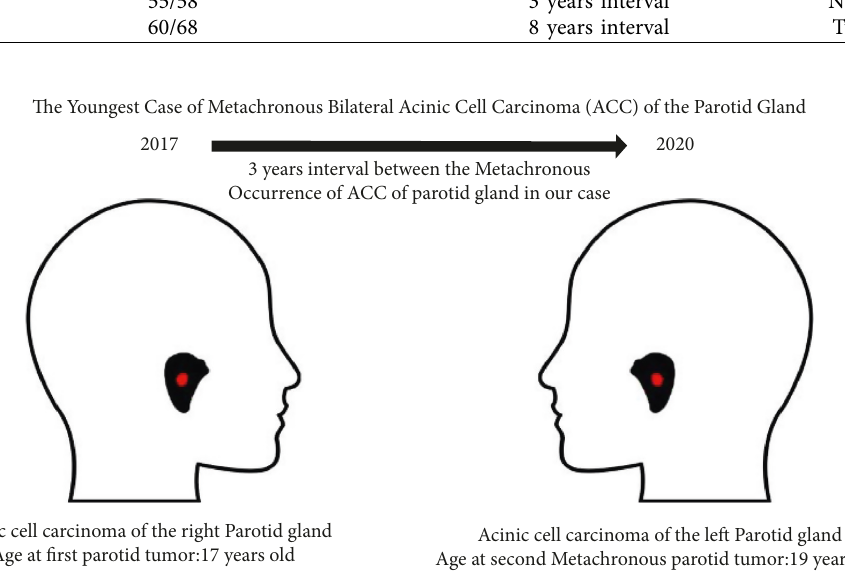
Figure 11: Representation of the bilateral metachronous occurrence of the parotid gland ACC in our